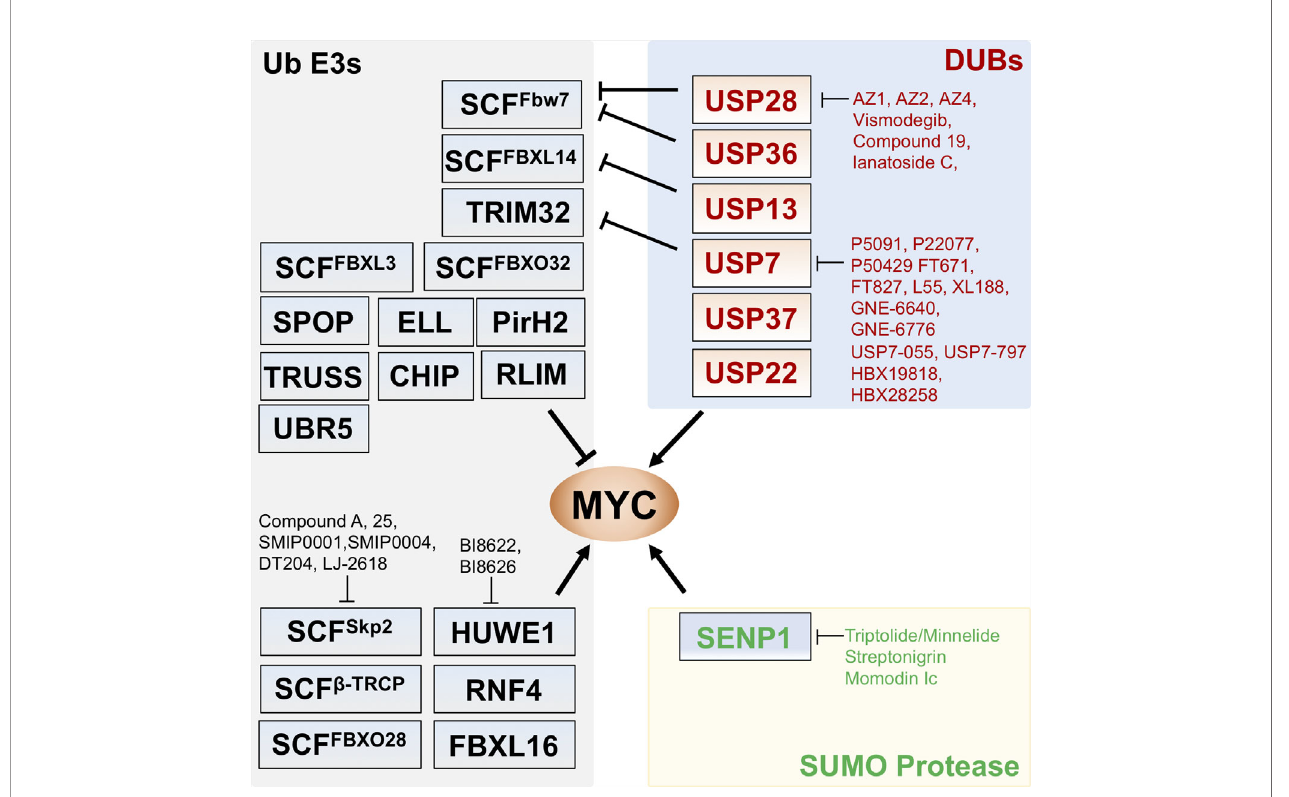
FIGURE 1 | Regulation of MYC by Ub ligases, deubiquitinating enzymes (DUBs), and SUMO protease. Shown are the known Ub ligases (left) mediating MYC ubiquitination, DUBs (upper right) for MYC deubiquitination and SENP1 (lower right) that deSUMOylates and stabilizes MYC. The arrows indicate positive regulation of MYC activity whereas the bars indicate the inhibition. Small molecule inhibitors targeting the indicated Ub ligases, DUBs, and SENP1 are